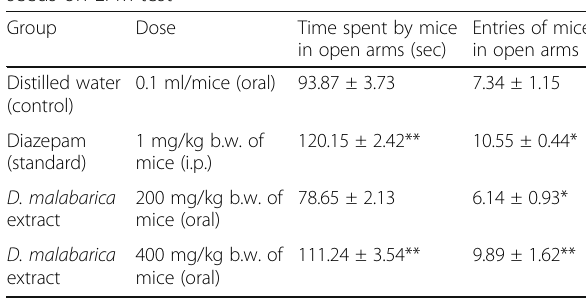
Table 1 Effect of the ethyl acetate extract of D. malabarica